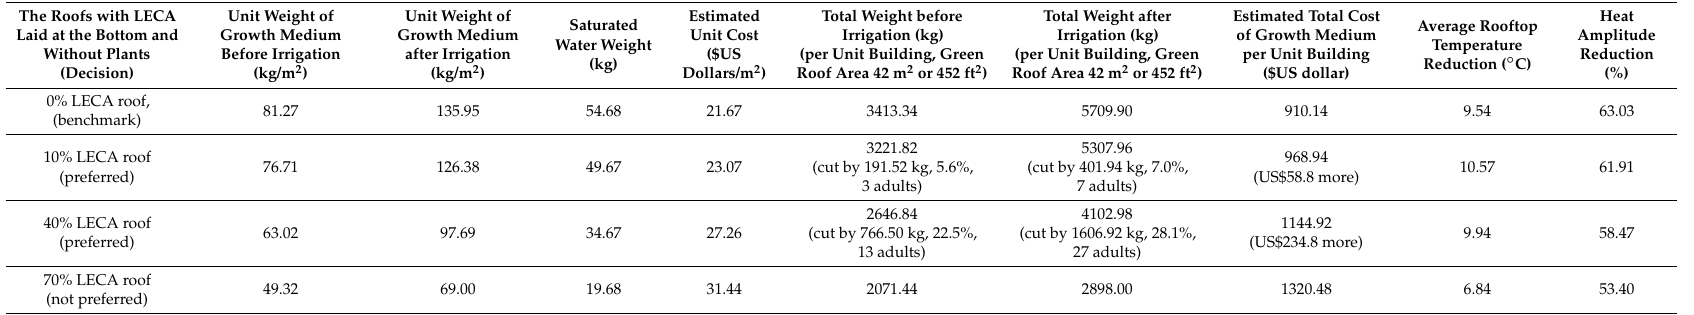
Table 15. Cost–benefit analysis of the LECA extensive